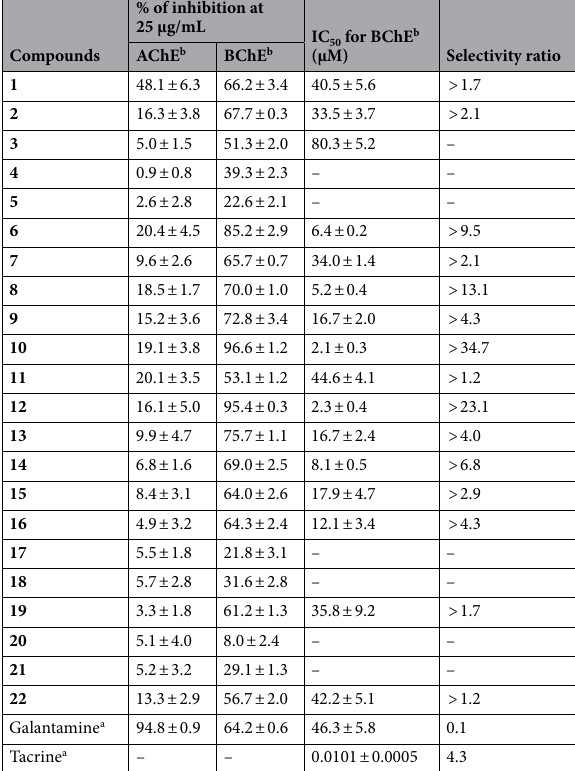
Table 1. Inhibition activity of phytochemicals isolated from B. striata against two cholinesterases. Selectivity ratio: % of inhibition at 25 μg/mL AChE /% of inhibition at 25 μg/mL BChE . a Positive control. b Data are the mean ± SD of three independent experiments. AChE from electric eel and BChE from equine